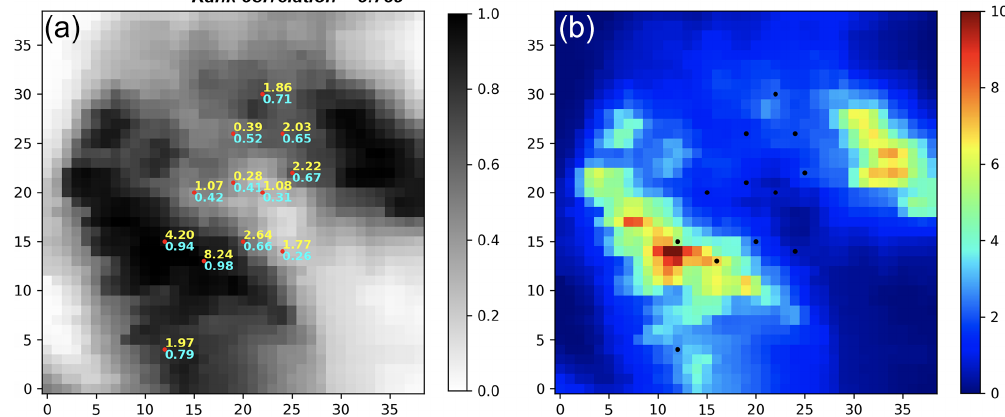
Figure 4. (a) The expected quantile map (–), with the rain gauge observations (mm) labeled in yellow and the collocated radar quantiles labeled in cyan. (b) The expected rainfall field (mm).